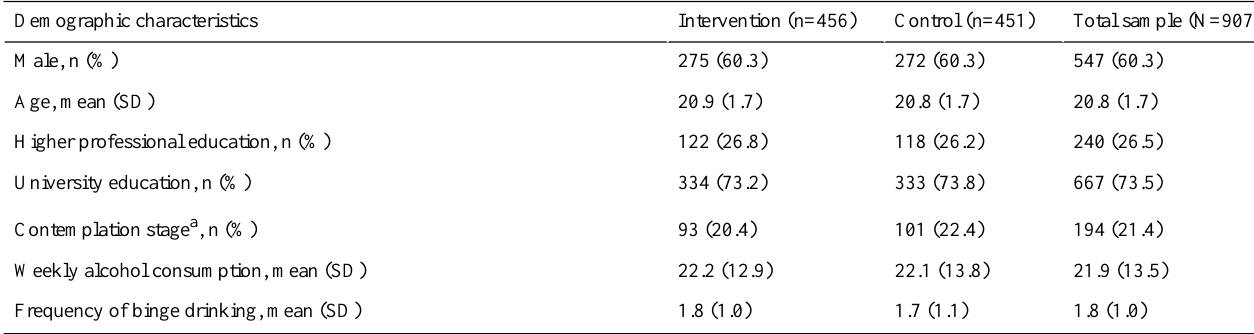
Table 1. Demographic characteristics and outcome measures at baseline